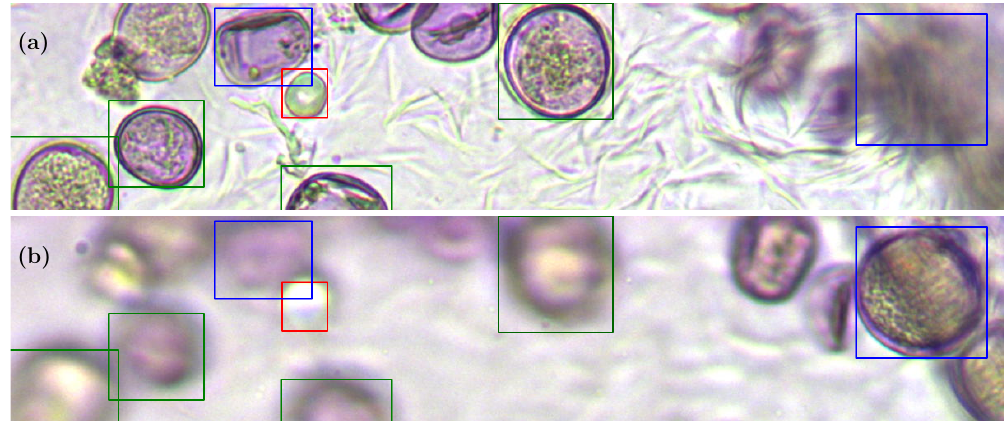
Figure 9. Two cuts in different focal planes that show two different errors: a false positive (red) that has a bubble marked as a pollen grain ( a ) and a false negative (blue box on the right) whose focal plane is far from those studied ( b